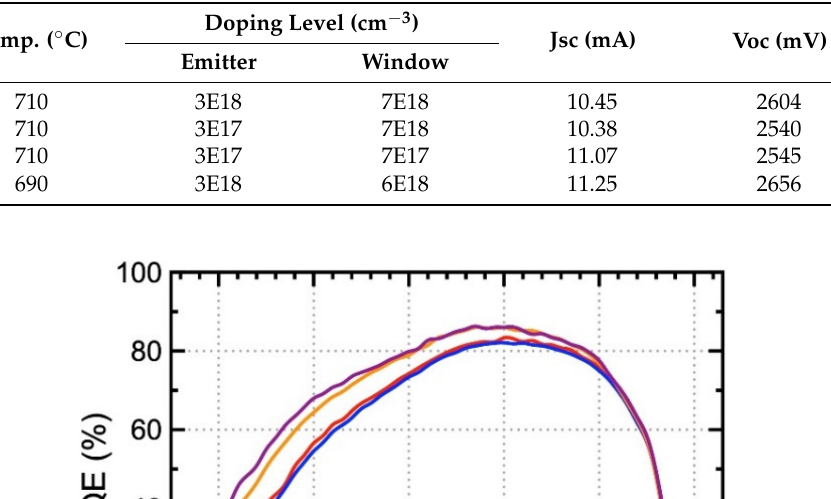
Table 2. Light J–V results of dual-junction solar cells (S-033, S-039, S-040 and S-043).